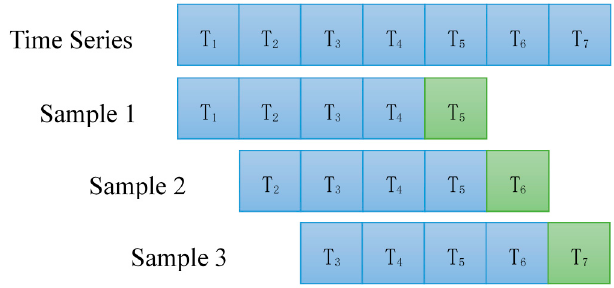
Figure 1. Sliding